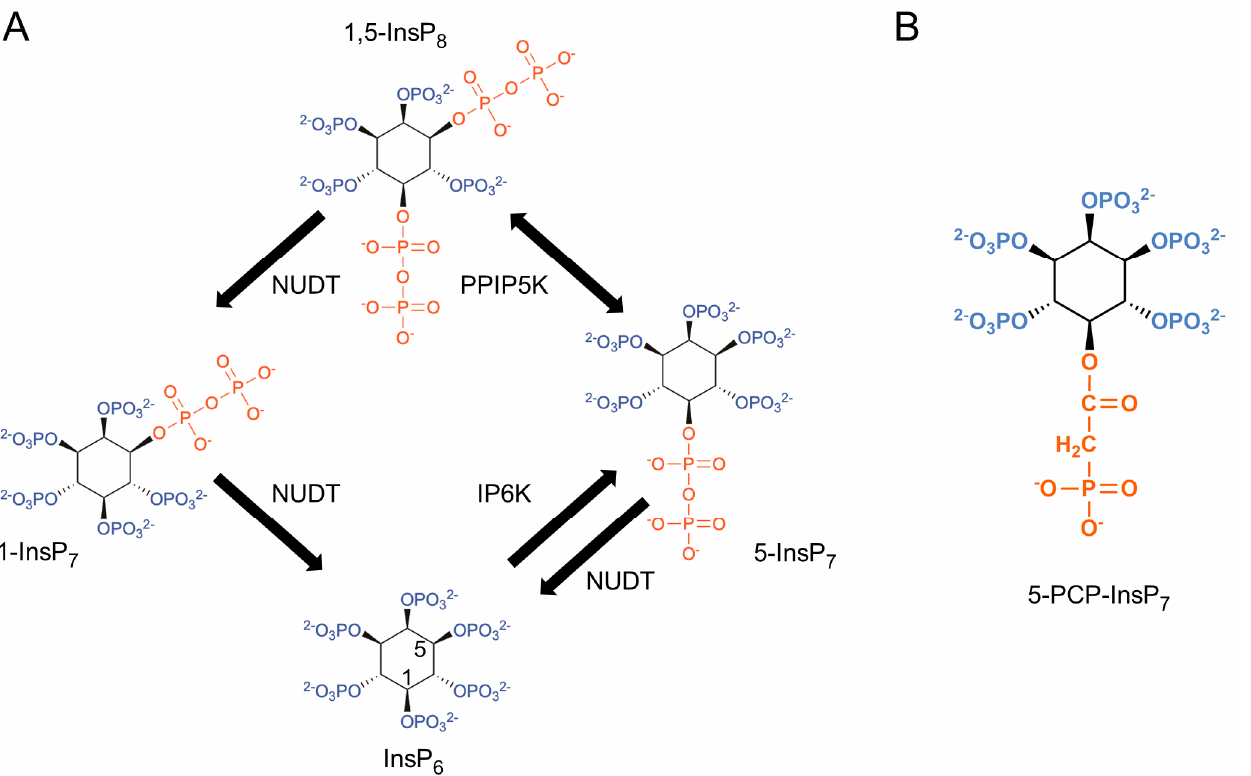
Figure 1. Structures of mammalian PP-InsPs and a metabolically resistant methylene bisphosphonate analog. ( A ) Structures of InsP 6 and PP-InsPs. The graphic shows the proposed cyclical pathway for their interconversion in mammalian cells [3]. Mammalian cells express three isoforms of IP6Ks (types 1,2, and 3) and two PPIP5Ks (types 1 and 2). The latter each possess a kinase domain that phosphorylates 5-InsP 7 to InsP 8 and a separate phosphatase domain that dephosphorylates InsP 8 back to 5-InsP 7 . NUDT3 (also known as DIPP1) is one of five mammalian NUDT isoforms in mammals that removes β -phosphates from both 5-InsP 7 and InsP 8 . Note that little 1-InsP 7 accumulates in HCT116 cells [4]. ( B ). Structure of metabolically resistant 5-PCP-InsP 7 .